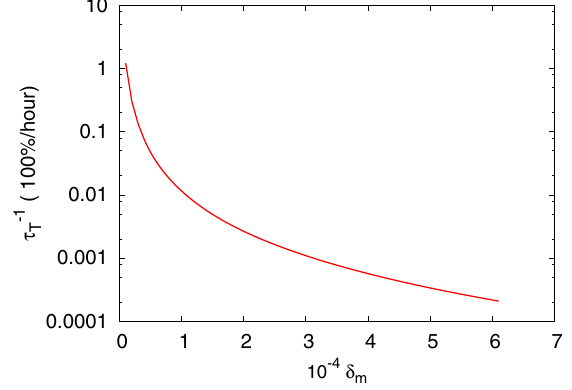
FIG. 12. The percentage of protons per hour having a relative momentum change δ m due to Touschek